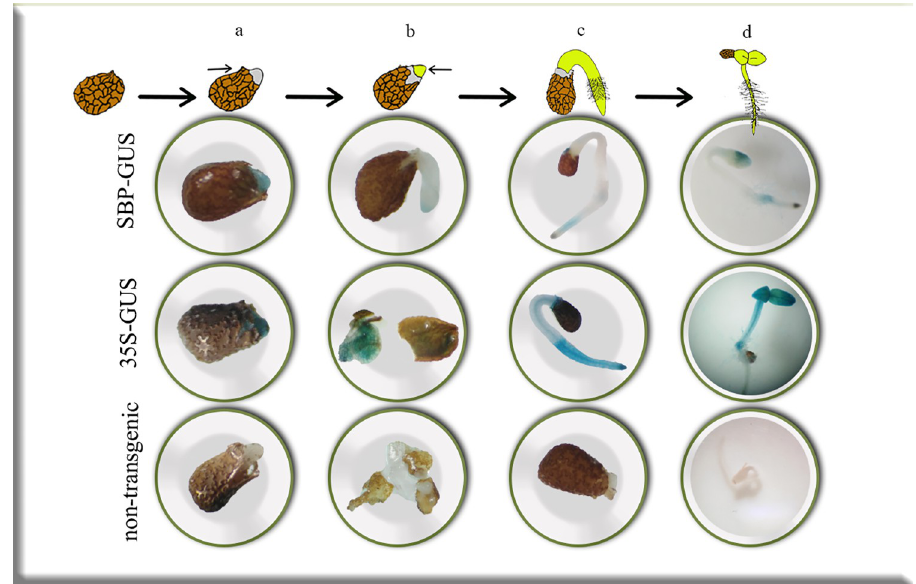
Fig 5. Histochemical GUS analysis in four stages of seed germination: a . endosperm appearance b . radical emerges c . radical growth and d . cotyledon appearance in SBP-GUS, 35S- GUS, and non-transgenic control plants. acids were Palmitic acid (16:0), Palmitoleic acid (16:1), Margaric acid (17), Stearic acid (18:0), Oleic acid (18:1.9), Vaccenic acid (18:1.11), Linoleic acid (18:2), Linolenic acid (18:3), and Ara-